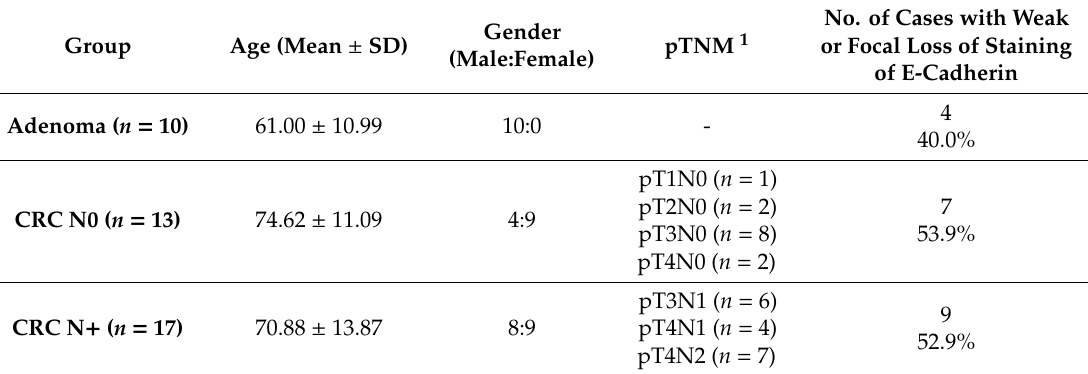
Table 2. Patients’ characteristics and results of immunohistochemistry for E-cadherin.